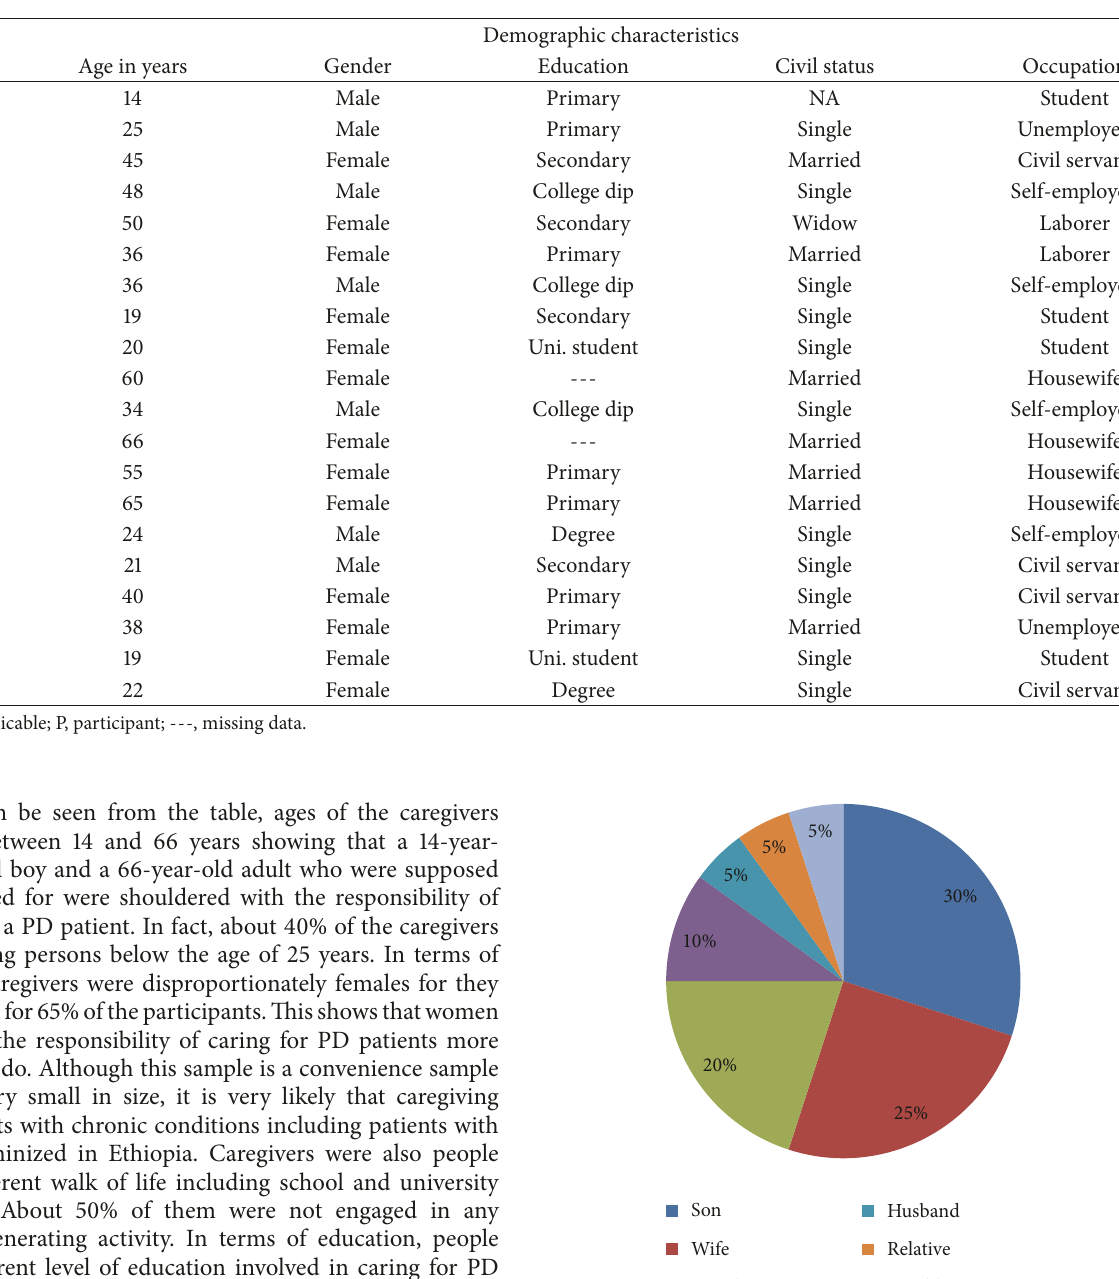
Table 1: Demographic information of participants.